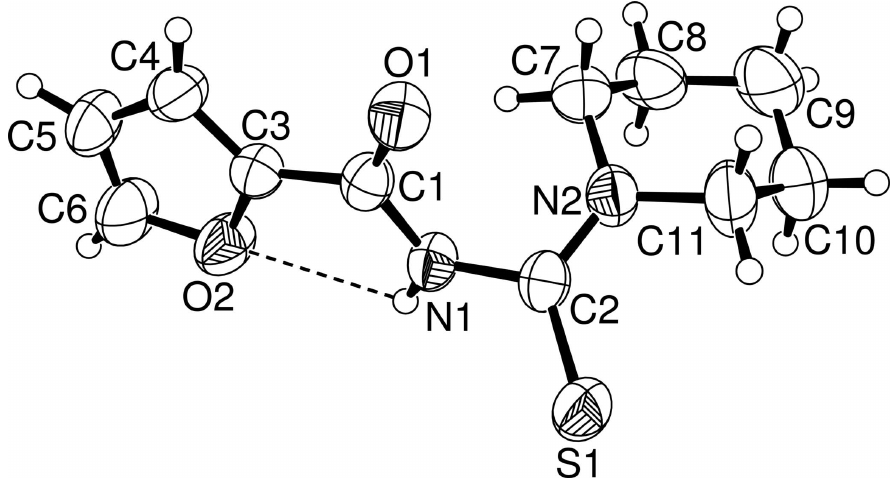
Figure 1 View of the molecular structure of the title compound (50% probability displacement ellipsoids). Intramolecular Hydrogen bonds (N1–H1···O2) are shown as dashed